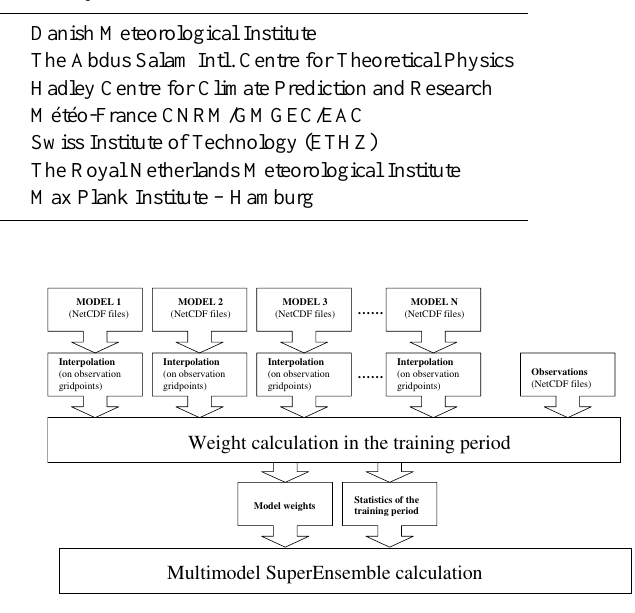
Fig. 3 : scheme of the standard Multimodel SuperEnsemble technique. Fig. 3. Scheme of the standard multimodel superensemble tech-